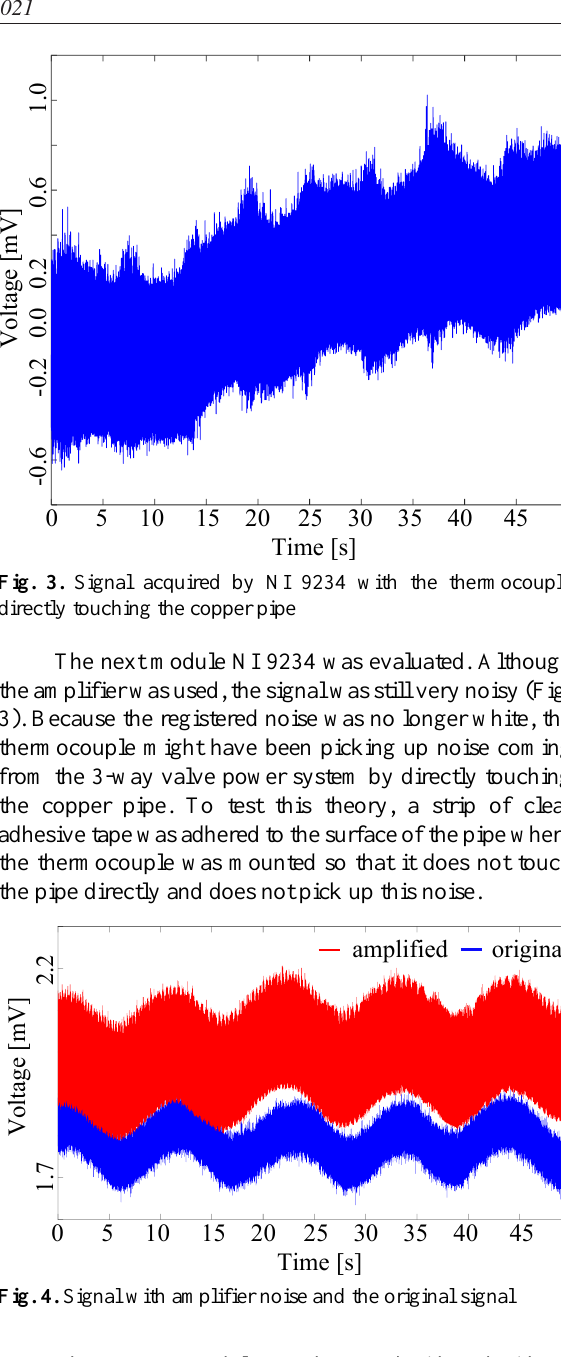
Fig. 6. Temperature deducted from amplified and smoothed